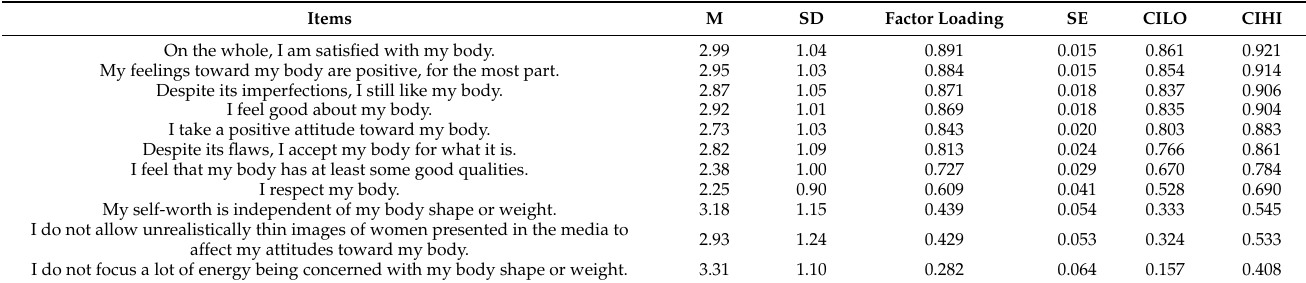
Table 1. CFA results for items of the final Body Appreciation Scale.